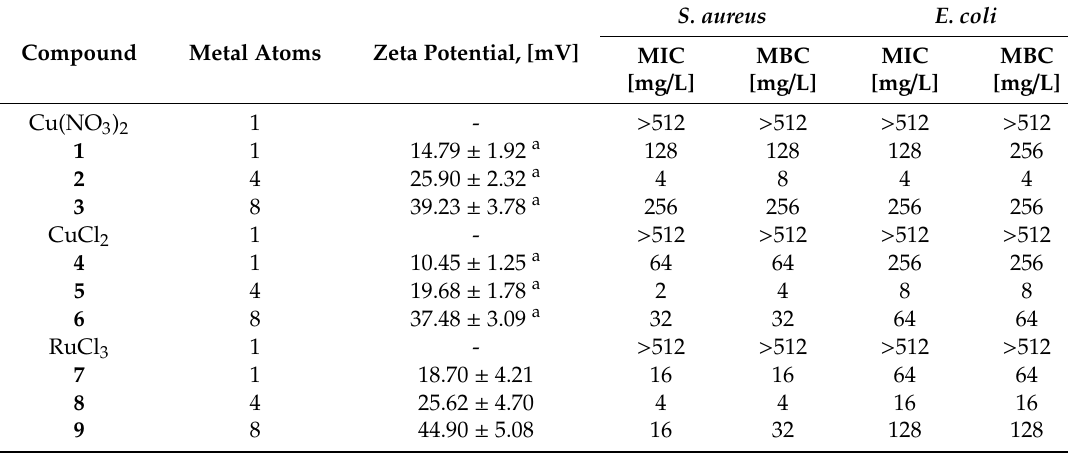
Bacteriostatic (Minimum Inhibitory Concentration, MIC) and bactericide (Minimum Bactericidal Concentration, MBC) e ff ect of carbosilane metallodendrimers in planktonic cells and comparative values of